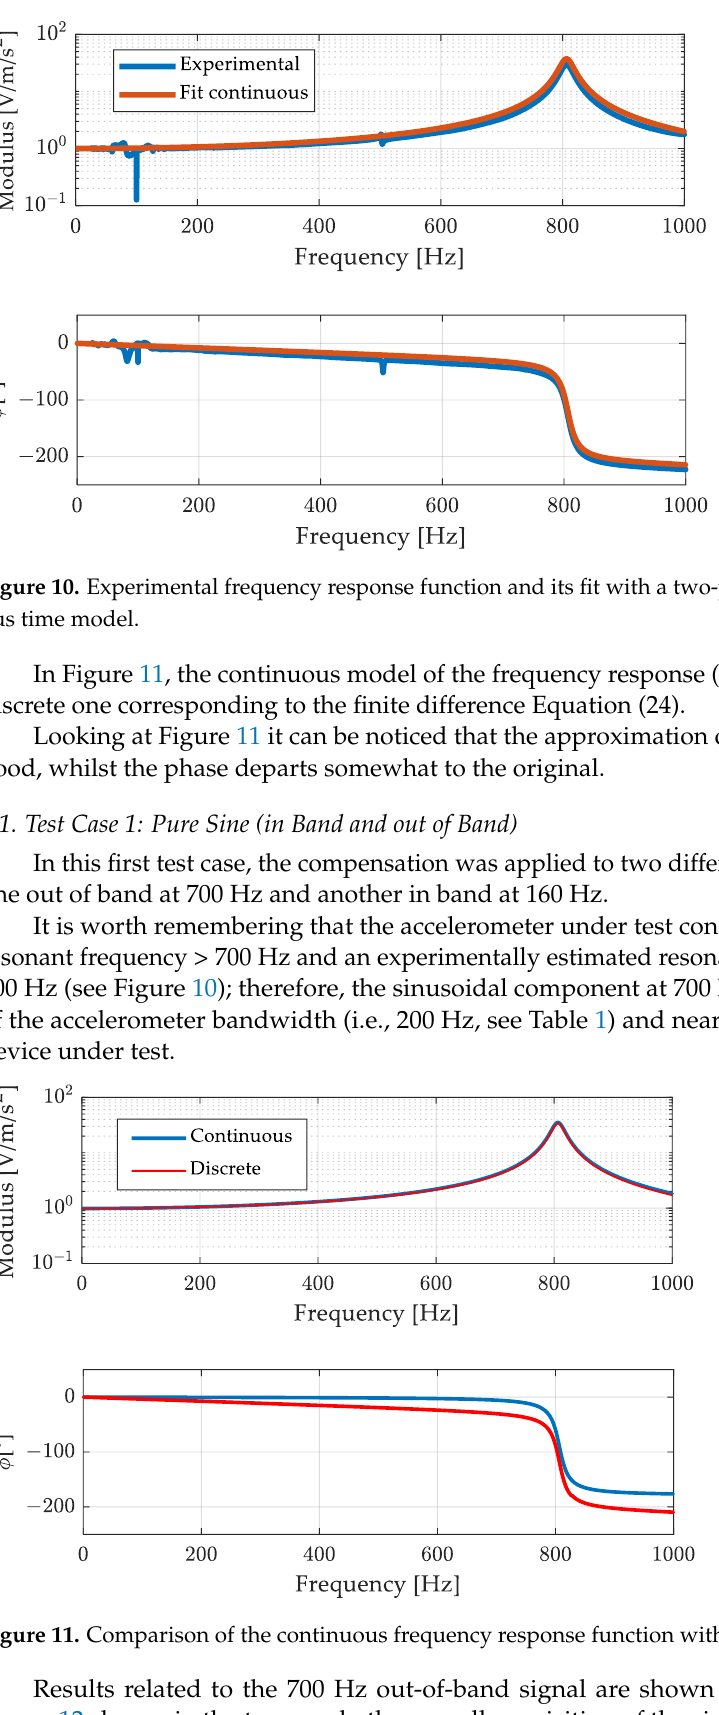
11 of 19 Figure 9. Power spectral density of the driving signal. The frequency response 𝑎 𝑇 (𝑓)/𝑎 𝑅 (𝑓) , where 𝑎 𝑇 and 𝑎 𝑅 are the acceleration meas- ured by the tested and reference accelerometer, respectively, was then obtained using the